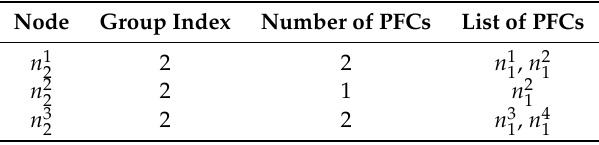
Table 2. The information from nodes in group